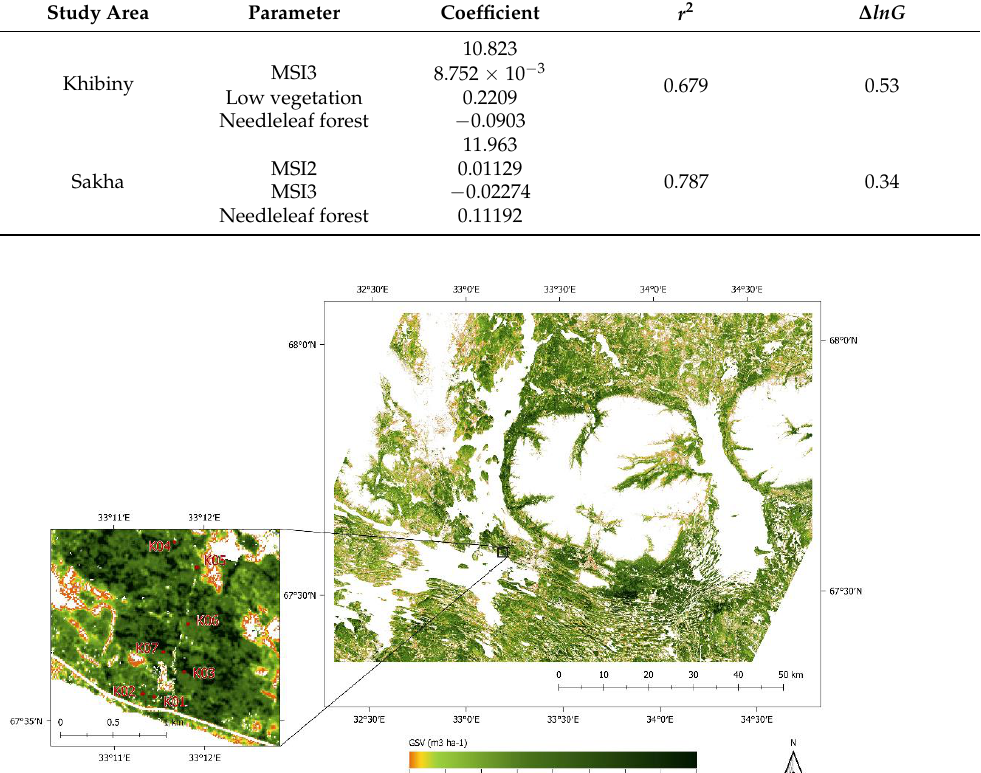
Table 5. Parameters and coefficients of the optimum GSV models defined by Equation (1), together natural logarithm of GSV from leave-one-out estimation. with r 2 coefficient of the fit to the field data and an estimate of the uncertainty ∆ lnG in fitting the natural logarithm of GSV from leave-one-out estimation.